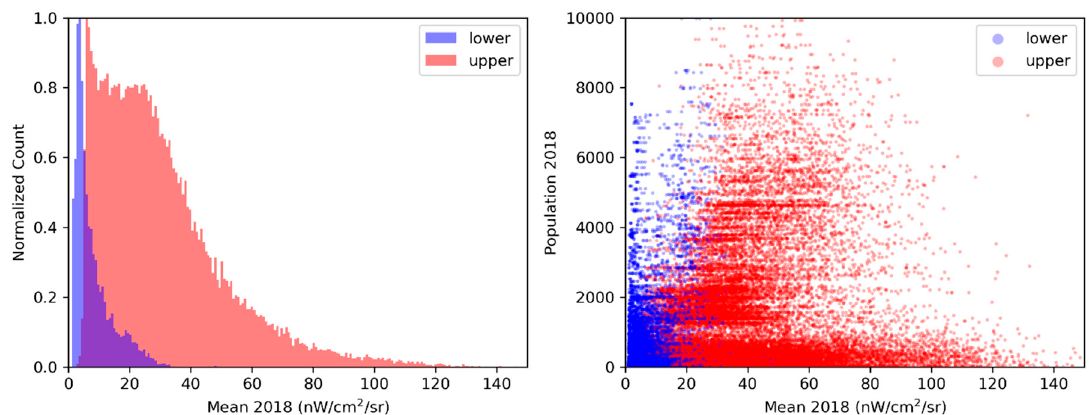
Figure 17. Histogram and scattergram of the 2018 mean values for the developing set (Harare, Nairobi, Dhaka, and Pyongyang) versus the developed set (Houston, Seoul, Shanghai, Beijing). The developed set is red and developing set is blue. The two sets are referred to as “lower” and “upper”, respectively. The sample set excludes grid cells deemed to be permanent background, where no lighting is detected. The scattergram is the mean versus population count from 2018.